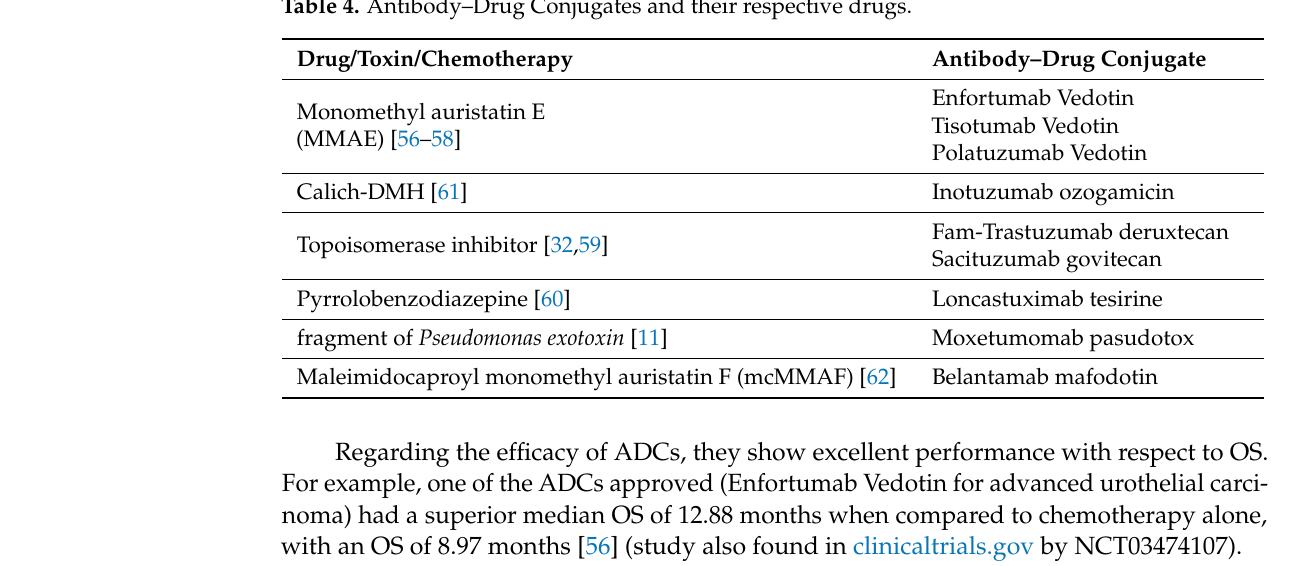
Table 4. Antibody–Drug Conjugates and their respective